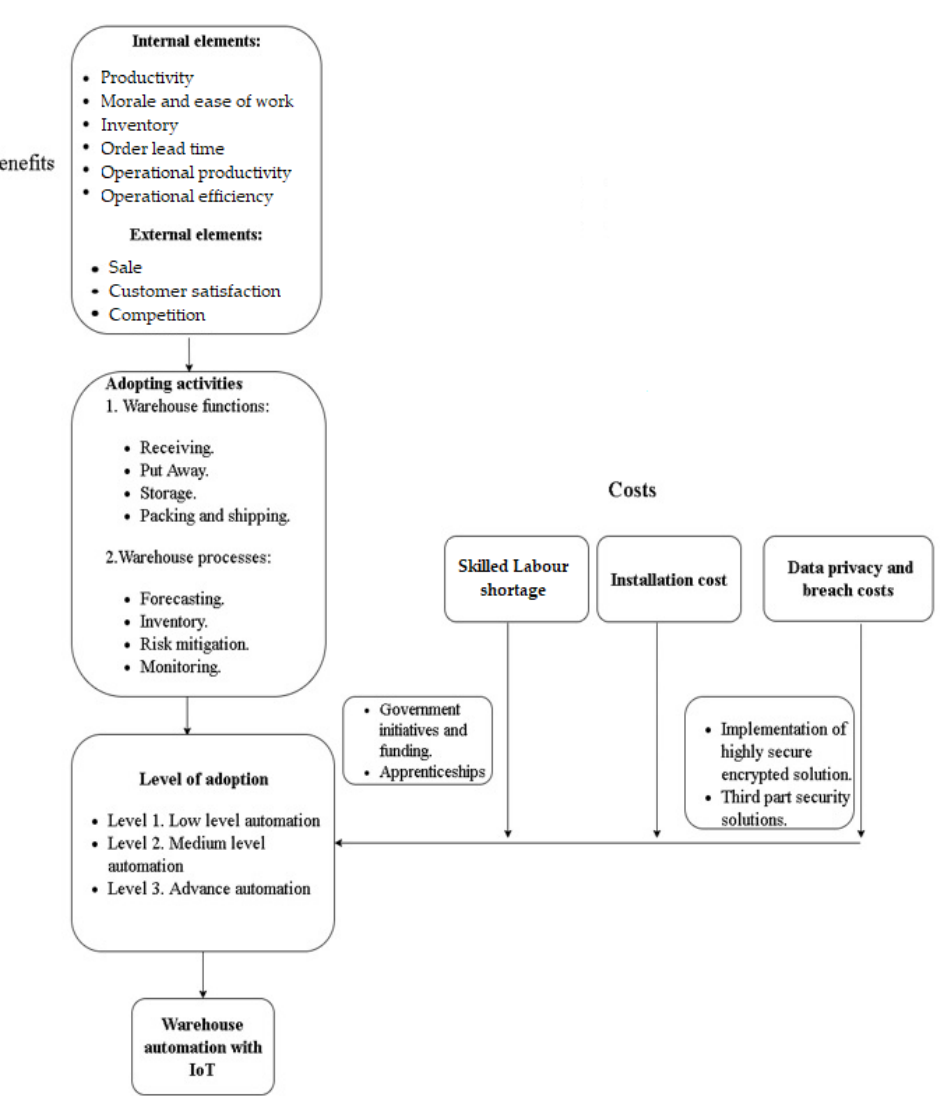
Figure 7. Conceptual model for the adoption of IoT measures in warehouse